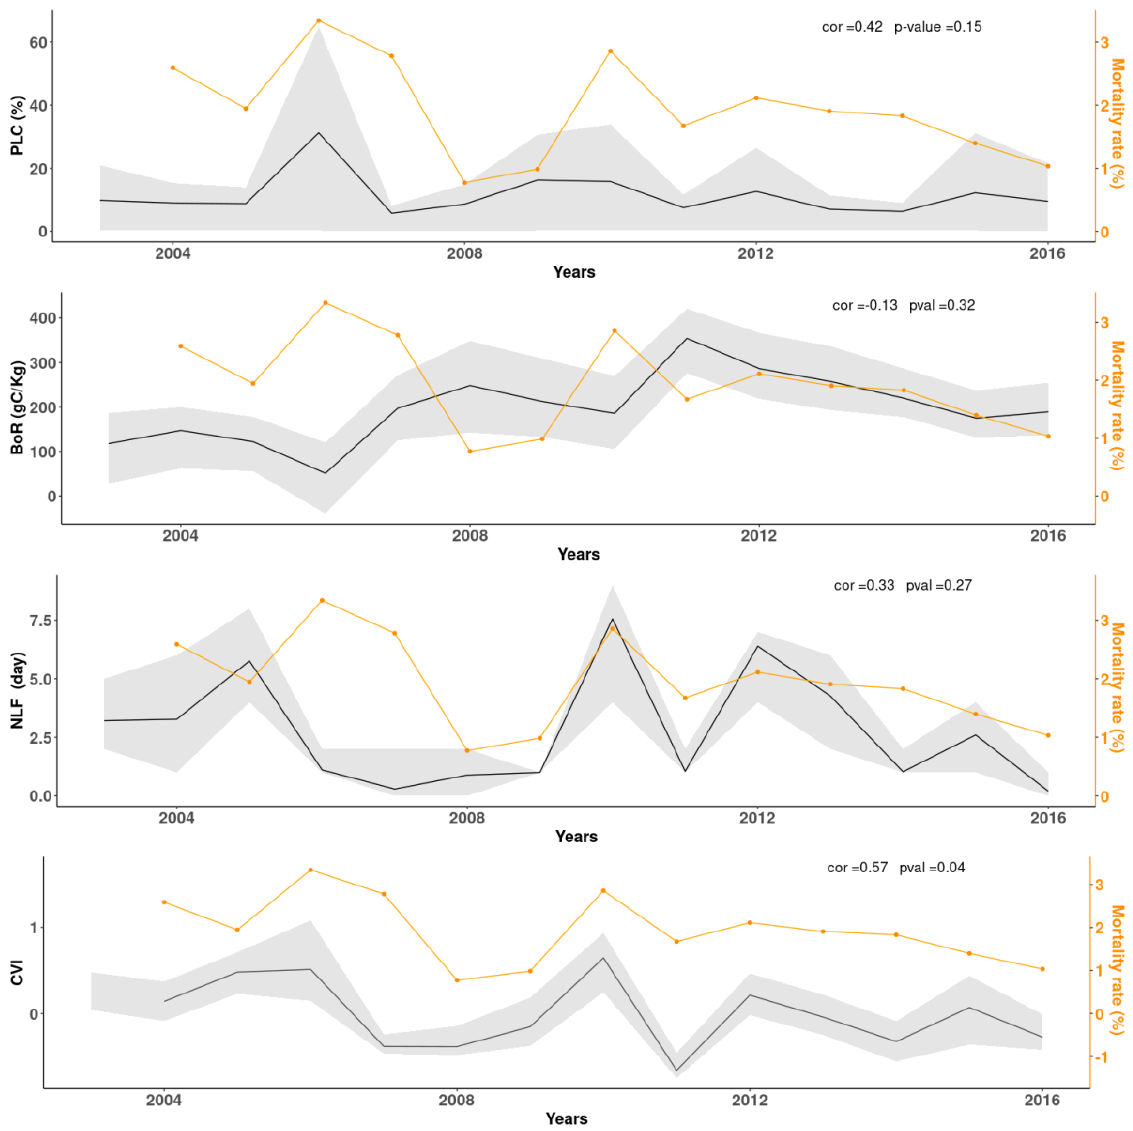
Figure 2. Stress-related output variable simulated with CASTANEA from 2004 to 2016: (a) percent loss of conductance (PLC); (b) biomass of reserves in gC.kg -1 (BoR); (c) number of late frost days (NLF); (d) Cumulated vulnerability index (CVI) integrating a, b and c. The black line is the mean of simulation, and the grey area represents the inter-individual variation from the 1 st to the 3 rd quartile. The yellow line is the mortality rate observed in La